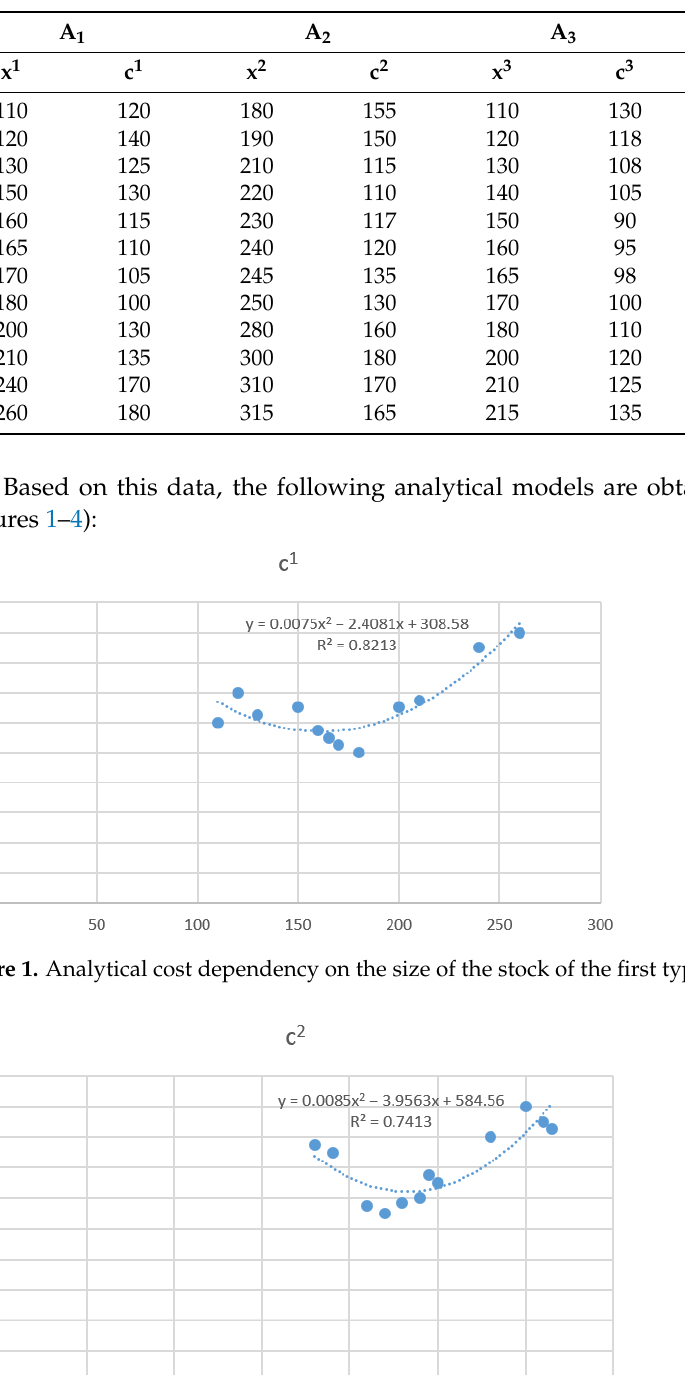
Figure 3. Analytical cost dependency on the size of the stock of the third type. Figure 4. Analytical cost dependency on the size of the stock of the fourth type. Thus, the functions describing analytically the dependence of costs on the quantity of stocks of each type shall accept the type: c 1 = 0.0075 (x 1 ) 2 − 2.4081 x 1 + 308.58,